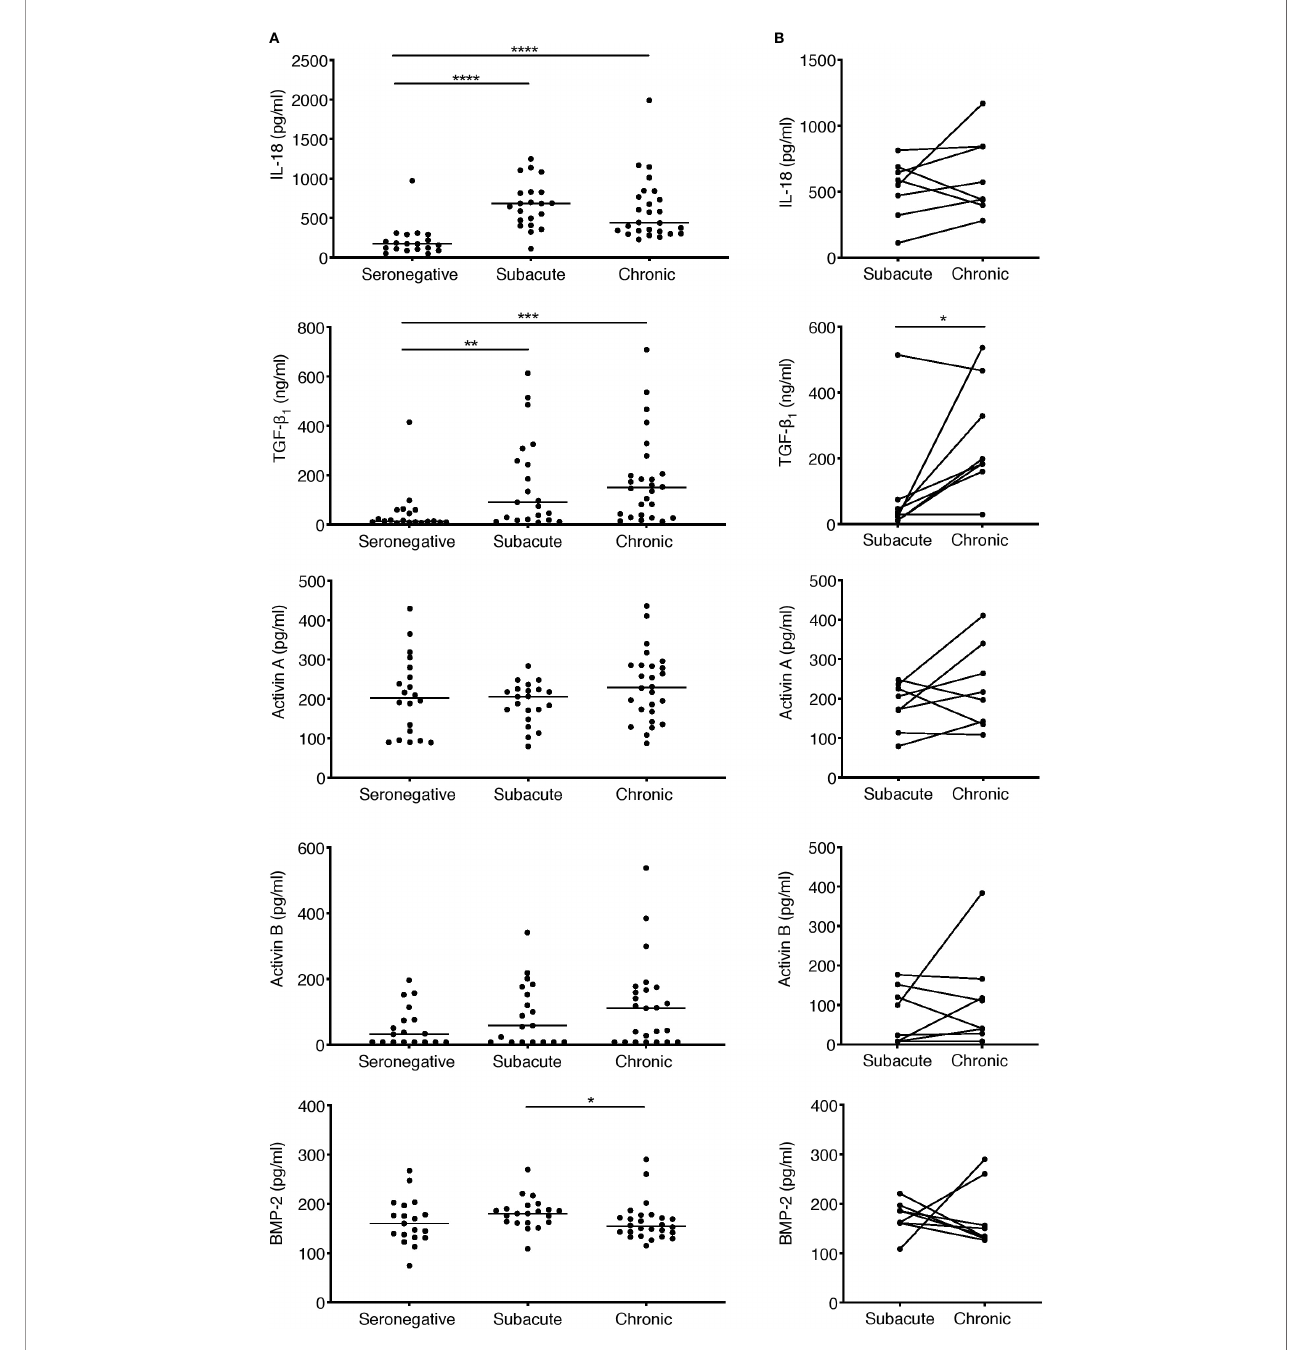
FIGURE 3 | Analysis of perturbations in plasma concentrations of IL-18 and TGF- b superfamily cytokines in subacute and chronic HIV-1 infection. (A) Concentrations of TGF- b superfamily cytokines and IL-18 were measured in plasma samples from HIV-infected individuals sampled cross-sectionally during subacute (within 30 days FOSx) or chronic (> 2 years FOSx) untreated infection, and in demographically matched HIV-seronegative control subjects. Symbols represent datapoints from individual subjects (n of datapoints included from seronegative, subacute and chronic groups: IL-18 and TGF- b 1 n=19, 21, 26; activin A n=20, 21, 26; activin B n=18, 19, 25; BMP-2 n=19, 21, 26); and horizontal lines denote group medians. The statistical signi fi cance of differences between groups was determined by Kruskal-Wallis test with Dunn ’ s post-test. (B) Samples were available from n=8 patients at time-points in both subacute and chronic untreated infection. Inter-time-point differences in cytokine levels in these subjects were compared by Wilcoxon signed-rank test (*P < 0.05, **P < 0.01, ***P < 0.001, ****P <